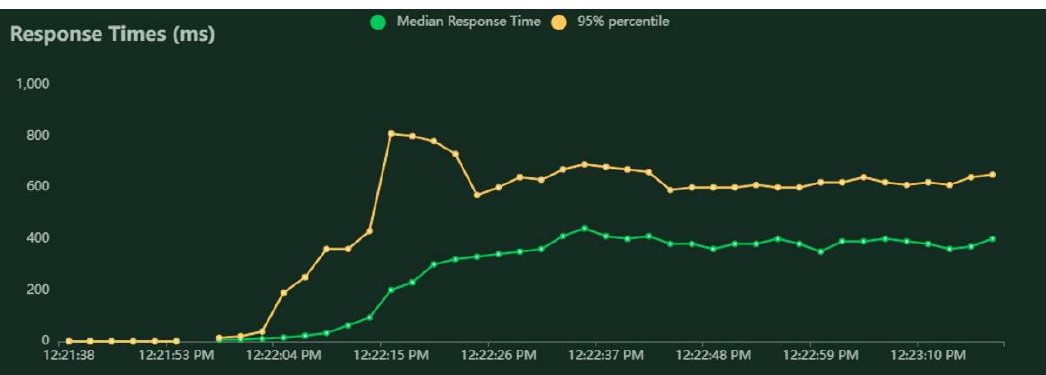
Figure 5. Response time for 1000 VUs and 0-policy.